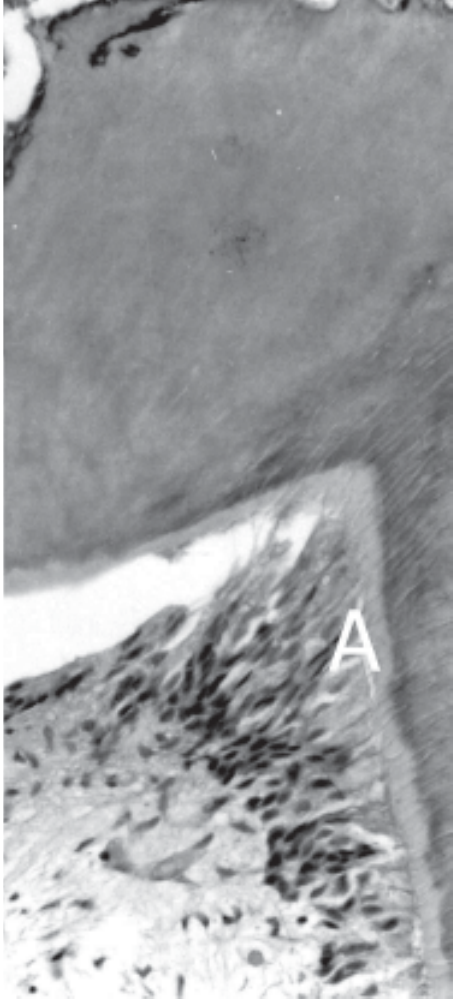
FIGURE 2 - MTA Angelus (120 days). H.E. 40 X. Presence of odontoblasts (A)